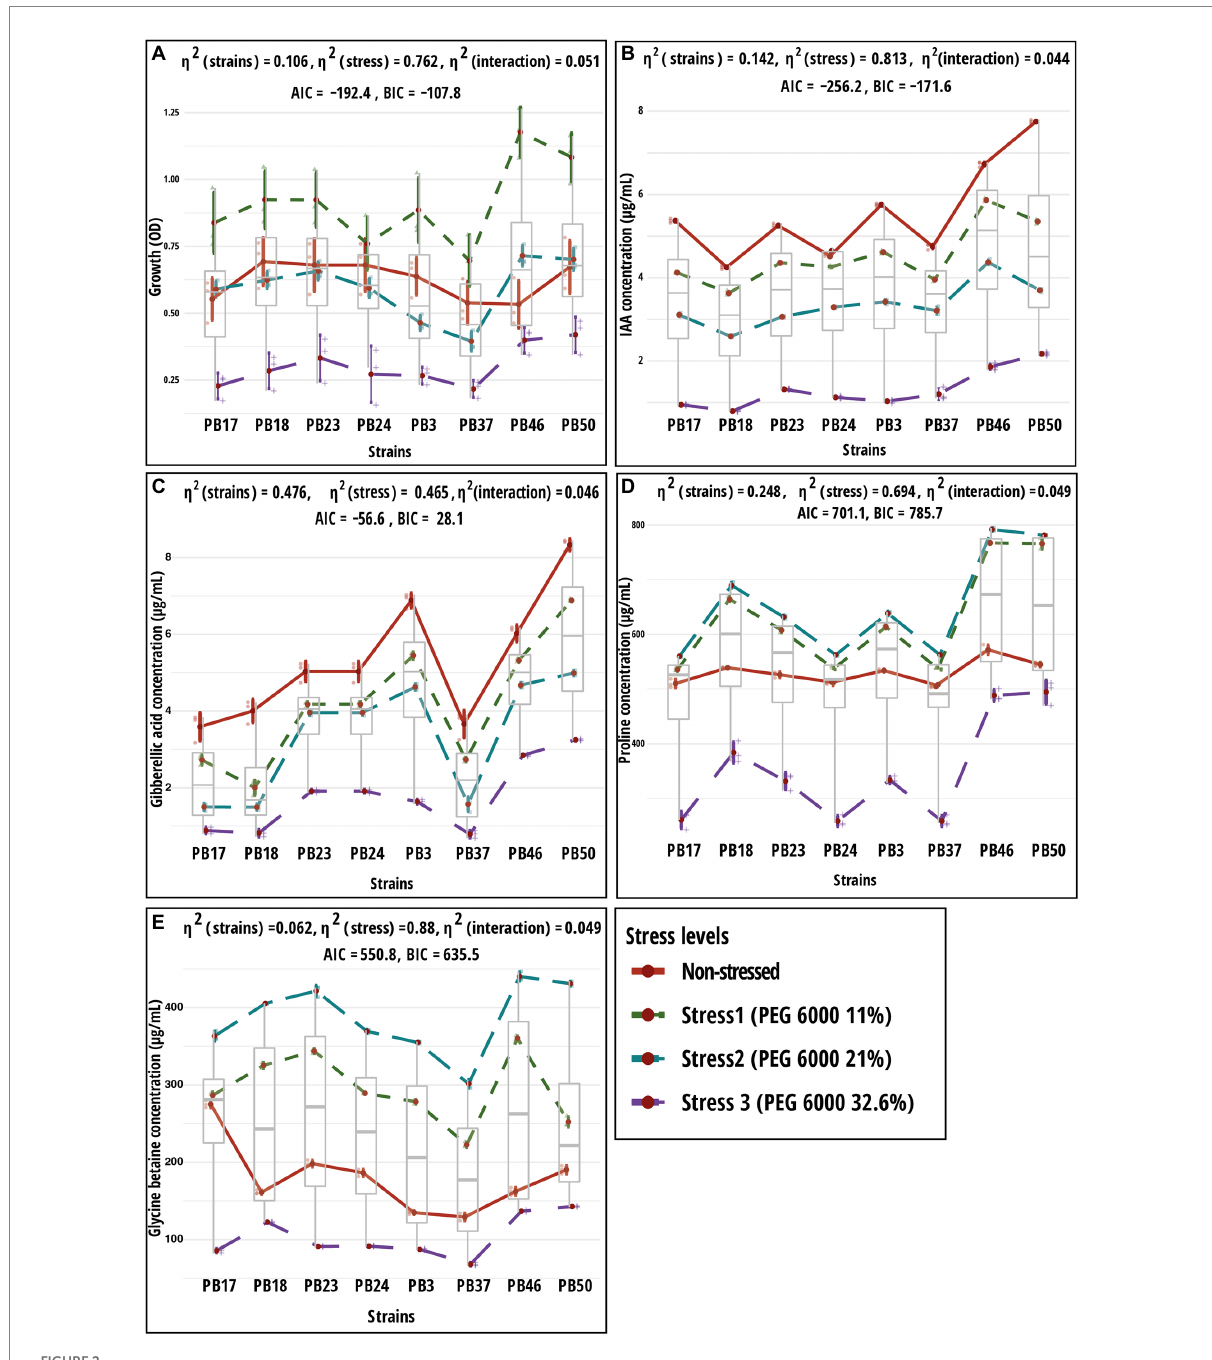
FIGURE 2 Results of two-way ANOVA showing the mean differences of dependent variables according to two independent variables (strain and stress) and their interaction. Shown are mean and standard error values for two grouping variables. Plots (A) growth; (B) indole-acetic acid (IAA); (C) gibberellic acid (GA); (D) proline; and (E) glycine betaine. The strain codes refer to the following strains: Bacillus endophyticus PB3, B . australimaris PB17, B . pumilus PB18, B . safensis PB23, S . sciuri PB24, B . altitudinis PB37, B . altitudinis PB46, and B . megaterium PB50. AIC, akaike information criterion; BIC, Bayesian information criterion; and η 2 , effect size. Individual p values are given in Supplementary Table